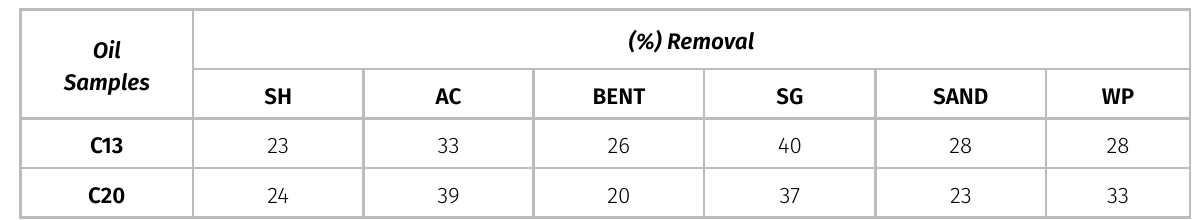
Table III. Compounds removal percentage from oil samples C13 and C20 by adsorbents, obtained by gravimetric